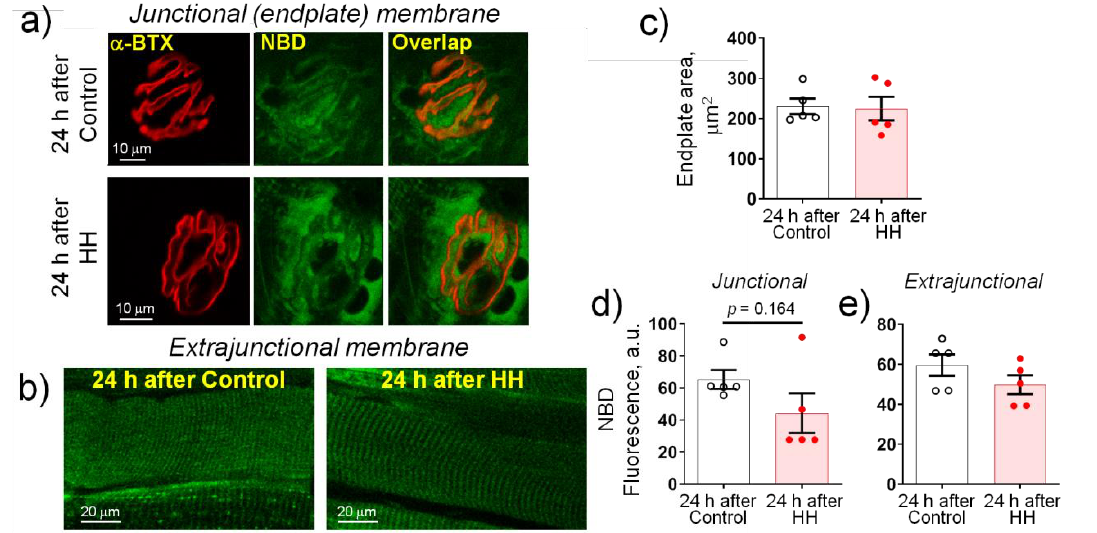
Figure 8. Exposure to hypobaric hypoxia (HH) at a pressure equivalent to an altitude of 3000 m for 3 h does not affect the membrane distribution of fluorescent 22-NBD-cholesterol in the rat diaphragm muscle. The measurements were carried out on muscles isolated 24 h after control or HH treatment. ( a ) Representative images of endplates dual-labeled with α -BTX (nAChRs, red channel) and 22-NBD- cholesterol (NBD, green channel). Overlap—orange. Scale bars—10 µ m. ( b ) Representative images of extrajunctional membrane regions. Scale bars—20 µ m. ( c ) Averaged area of endplates. ( d , e ) Averaged fluorescence intensity from the 22-NBD-cholesterol staining (arbitrary units) in the junctional ( d ) and extrajunctional ( e ) membrane regions. The number of muscles corresponds to the number of symbols. Two-way ANOVA followed by Bonferroni multiple comparisons test.